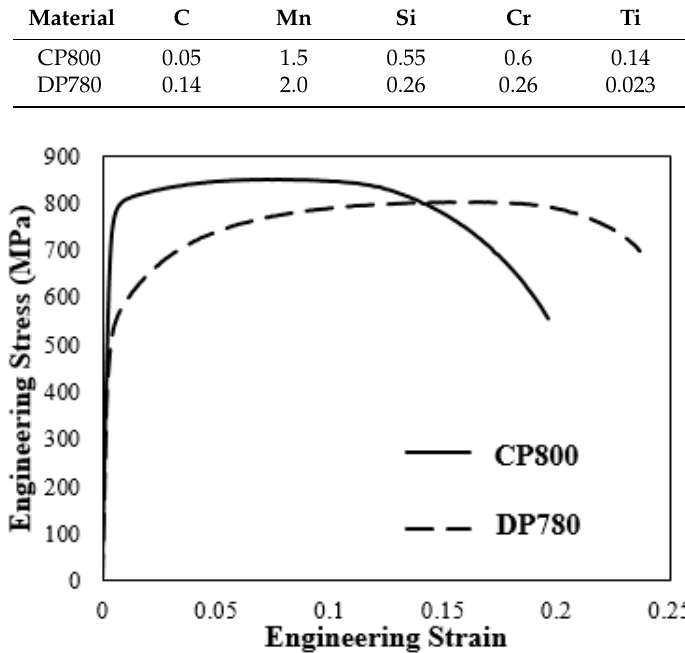
Figure 1. Engineering stress-strain curves (TD) for the CP and DP steels at 0.003 s − 1 strain rate [7]. Undeformed samples of the as-received steel sheet were mounted in epoxy and polished to